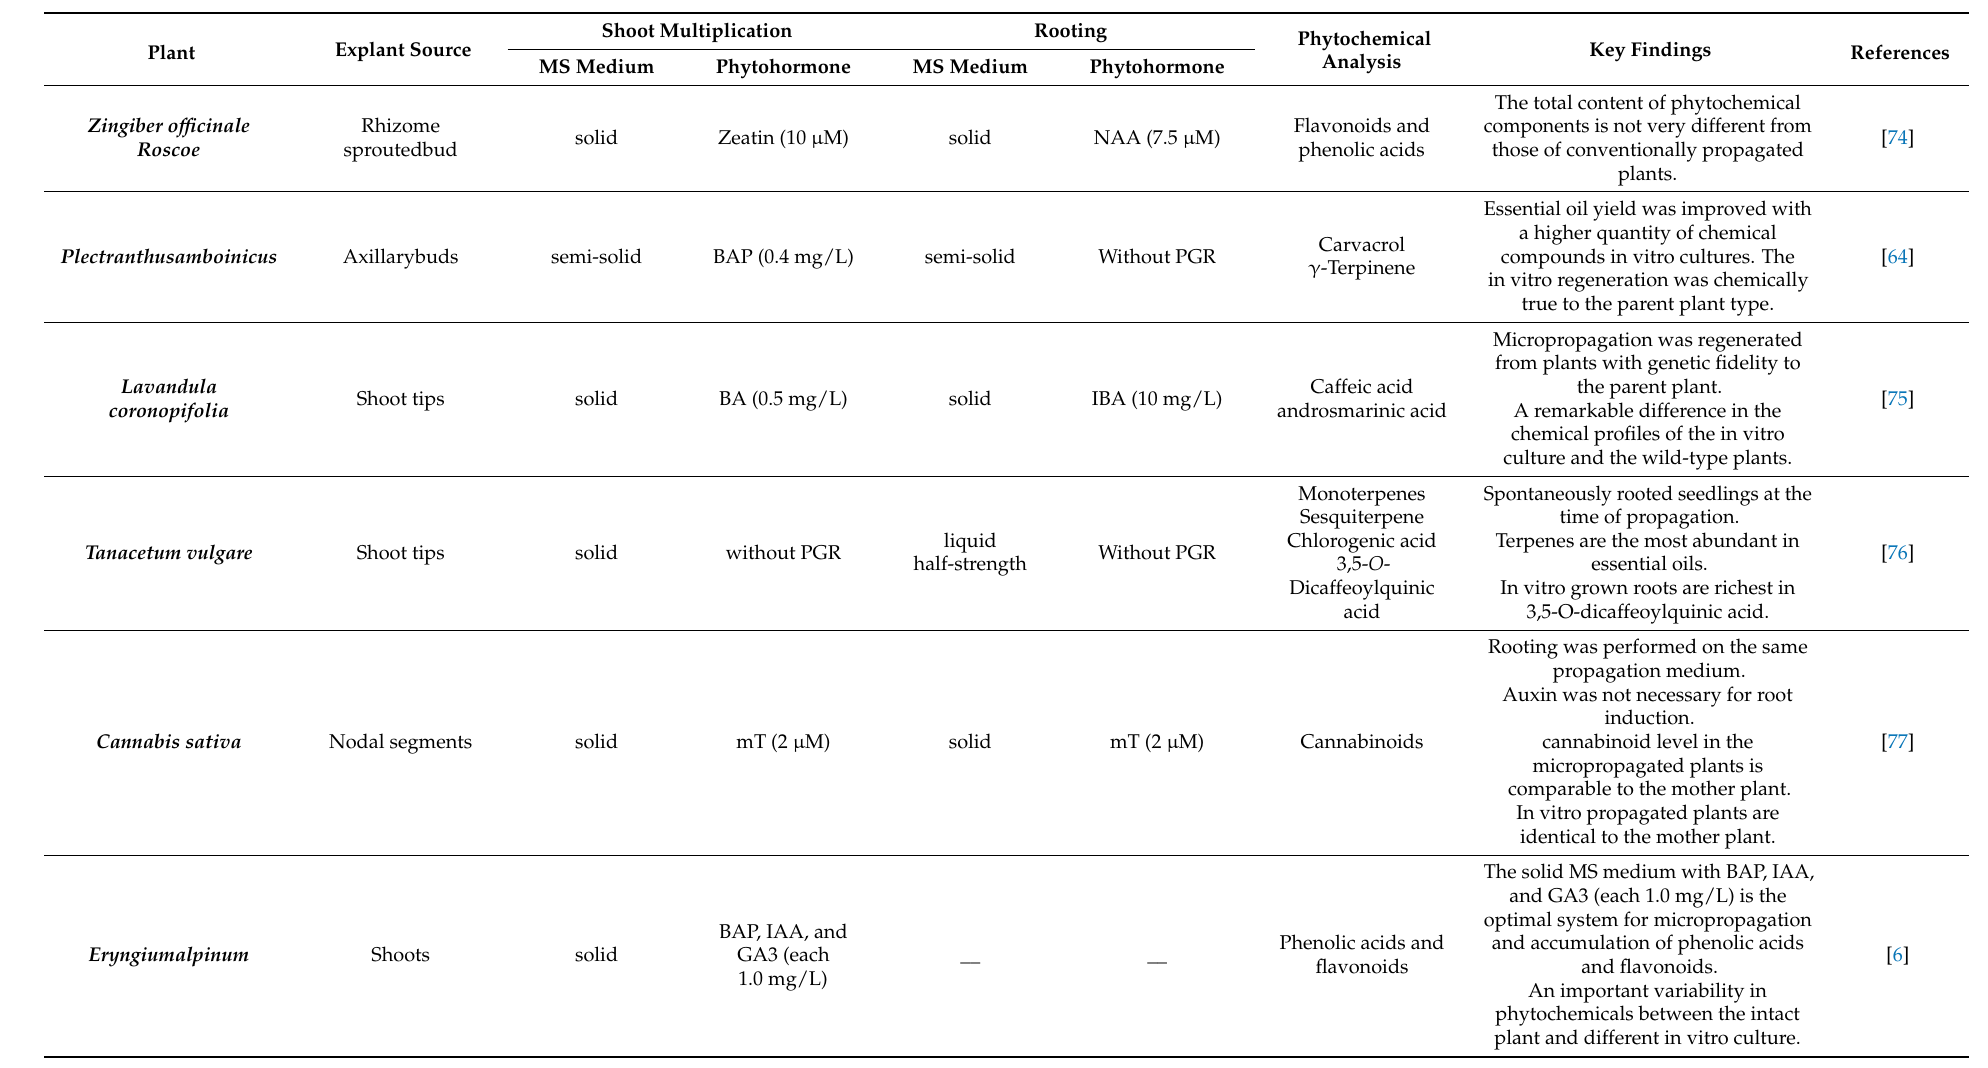
Table 1. Micropropagation of medicinal plants by organogenesis